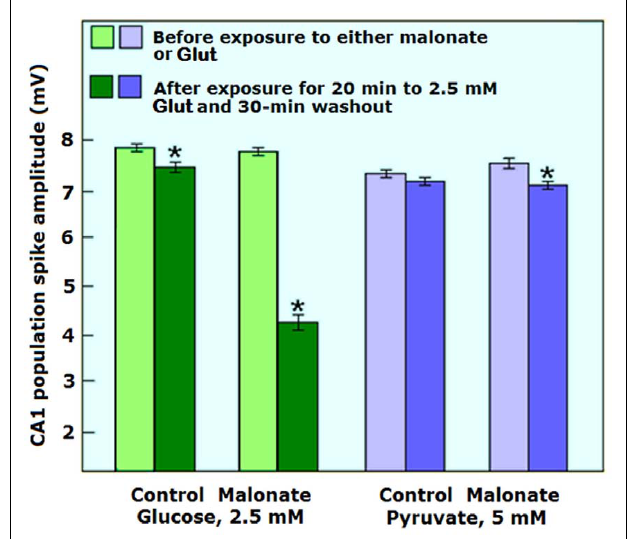
FIGURE 6 |The effect of 20min exposure to glutamate (Glut, 2.5mM) on hippocampal CA1 evoked population spike (PS, neuronal function) in the absence or presence of the LDH inhibitor, malonate (10mM) when either glucose (2.5mM) or pyruvate (5mM) was the sole energy substrate. Slices maintained in glucose aCSF could not recover their PS amplitude following Glut washout in the presence of malonate as compared to those maintained in the absence of malonate or those maintained with pyruvate whether malonate was absent or present. Slices were exposed to malonate throughout the experimental protocol for a total of 80min (30min before the exposure to Glut, 20min during the exposure to Glut and 30min during Glut washout). Each data point was repeated three times (30–36 slices). Bars are means ± SEM; *significantly different from the mean values before exposure to either malonate or Glut ( p < 0.01). For additional methodological details see Schurr and Payne